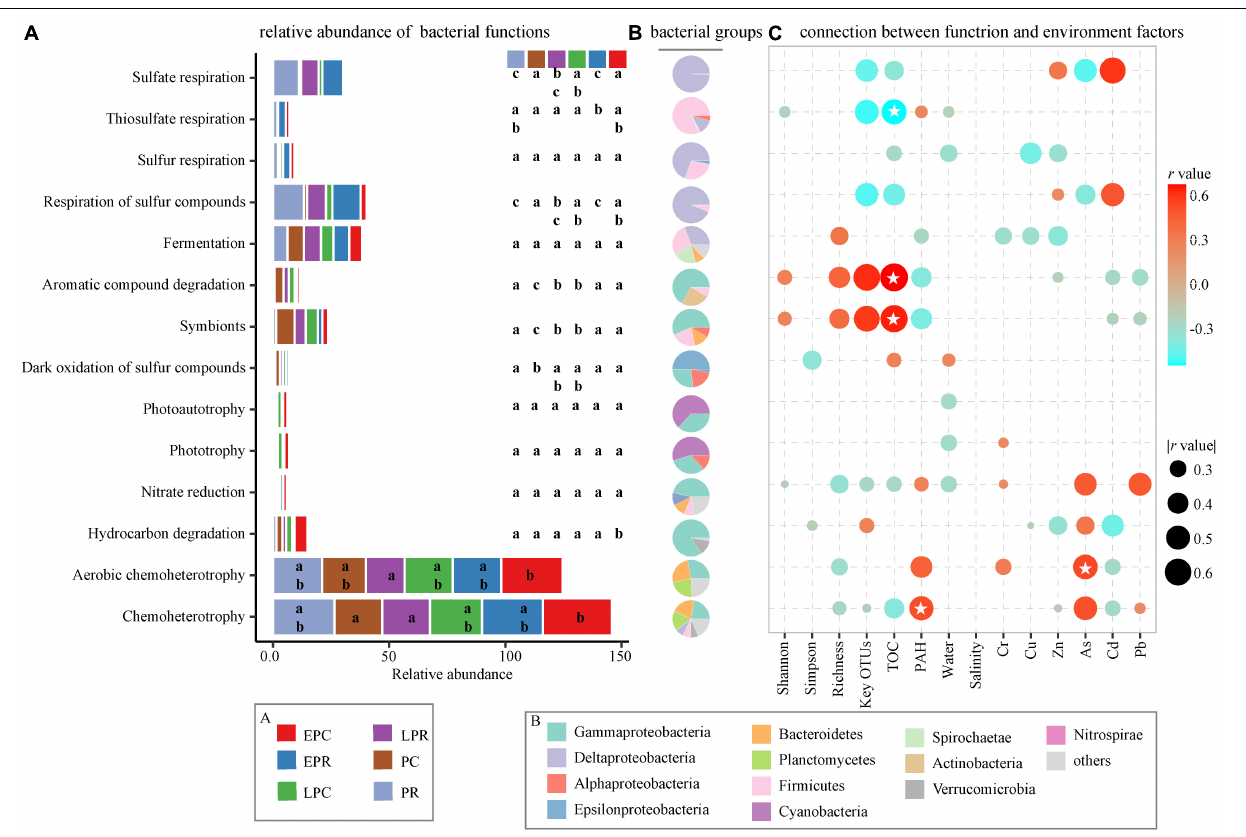
FIGURE 7 | Bacterial ecological roles during the restoration time. (A) The relative abundance of different bacterial functions. The color presents different groups, consistent with the color in Figures 3 , 5 , 6 . (B) The main bacterial phylum contributed to the ecological functions. The different colors stand for the bacterial taxon. (C) The connection between bacterial function and soil environmental factors. | r | > 0.3, * stands for p <